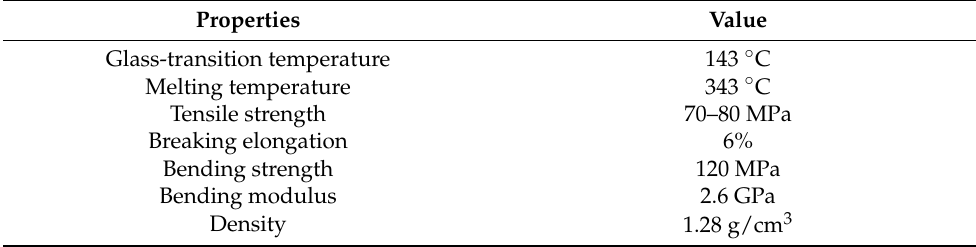
Table 2. The definition of various parameters.